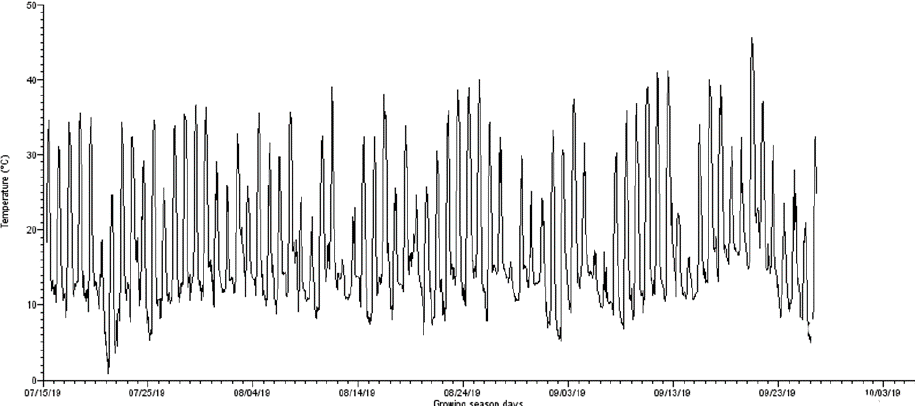
Figure 1. Average maximum and minimum temperatures recorded in the greenhouse during the 2019 growing season.